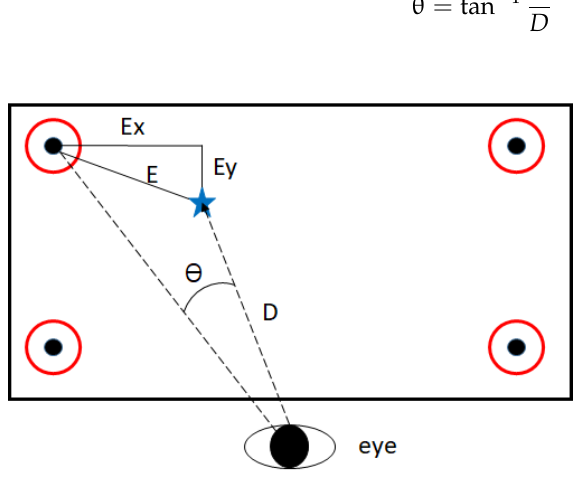
Figure 15. Diagram of estimating gaze tracking errors.